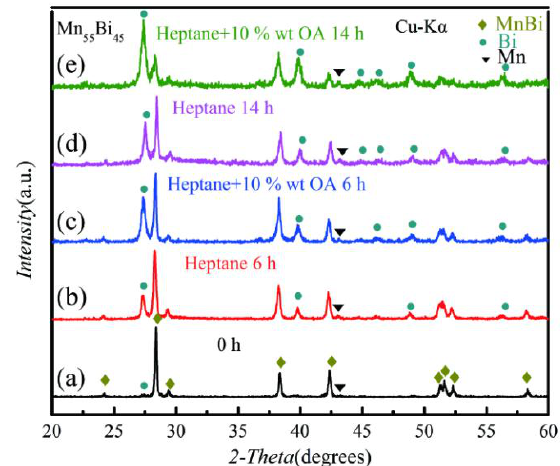
Figure 3. XRD patterns of Mn 55 Bi 45 powders obtained by different ball milling processes at different milling time: ( a ) After annealing, ( b ) By LEBM at 6 h, ( c ) By SALEBM at 6 h, ( d ) By LEBM at 14 h and ( e ) By SALEBM at 14h.